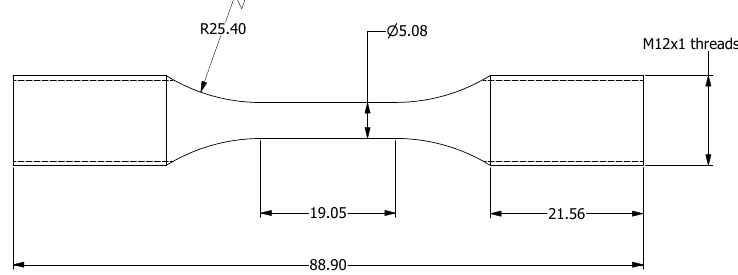
Figure 3. LCF specimen geometry (in